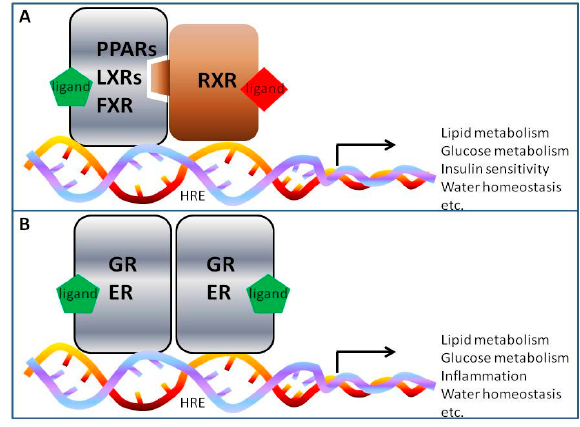
Figure 2. Schematic modes of nuclear receptor (NR) actions ( A , B ). HRE, hormone response element.